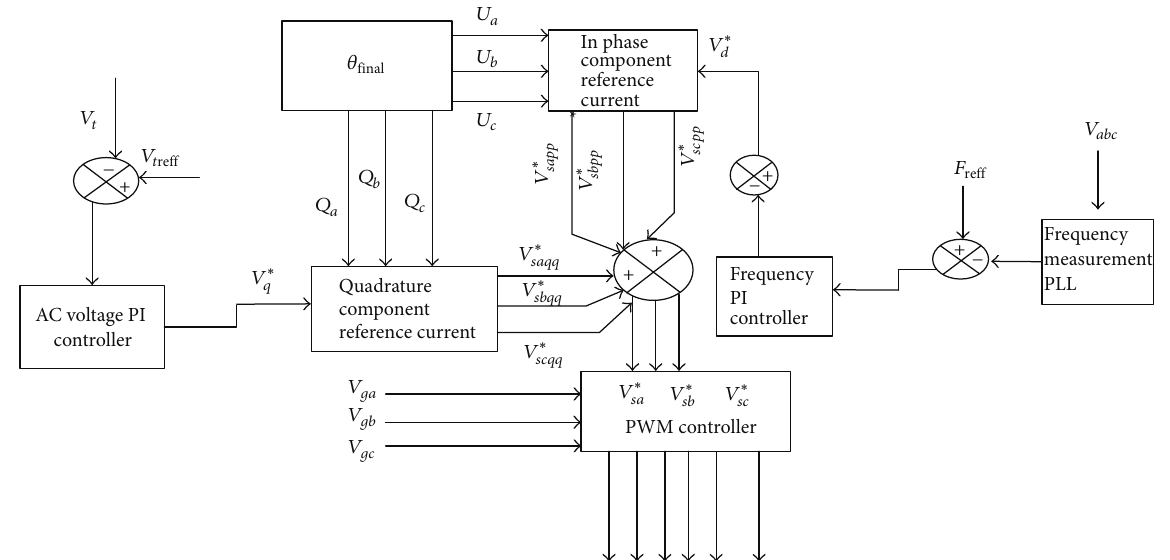
Figure 5: Control scheme for master controller for phase angle generation, voltage, and frequency regulation in microgrid.